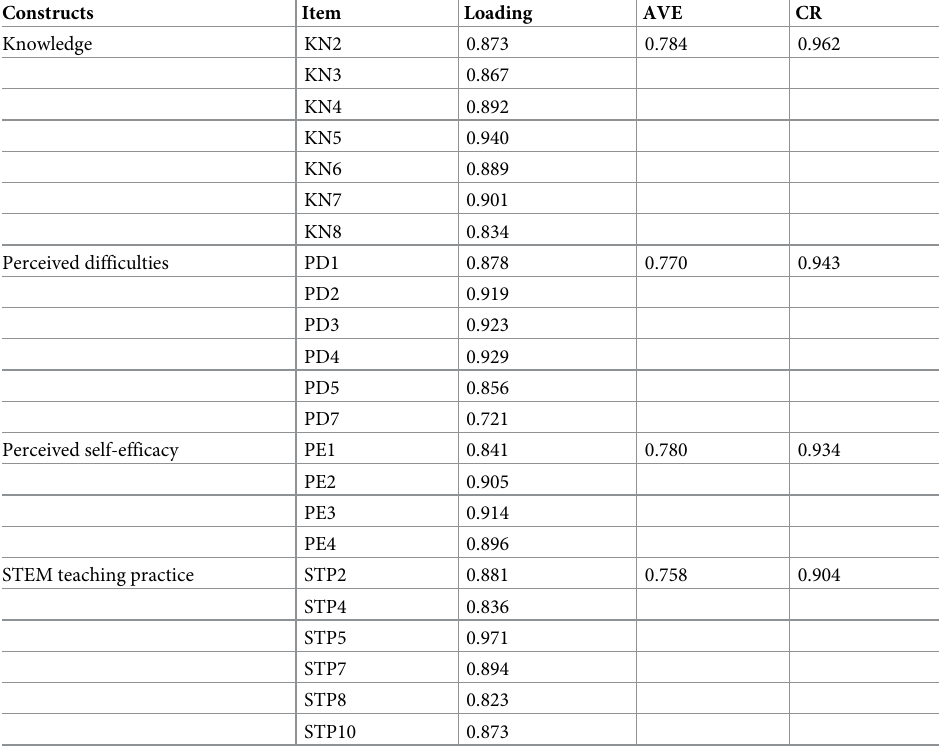
Table 1. Outer loading, mean, and standard deviation of items.